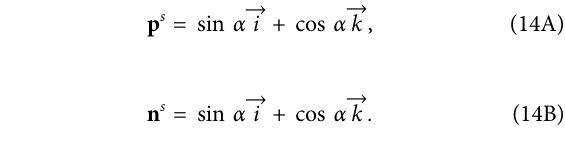
Frontiers in Earth Science |